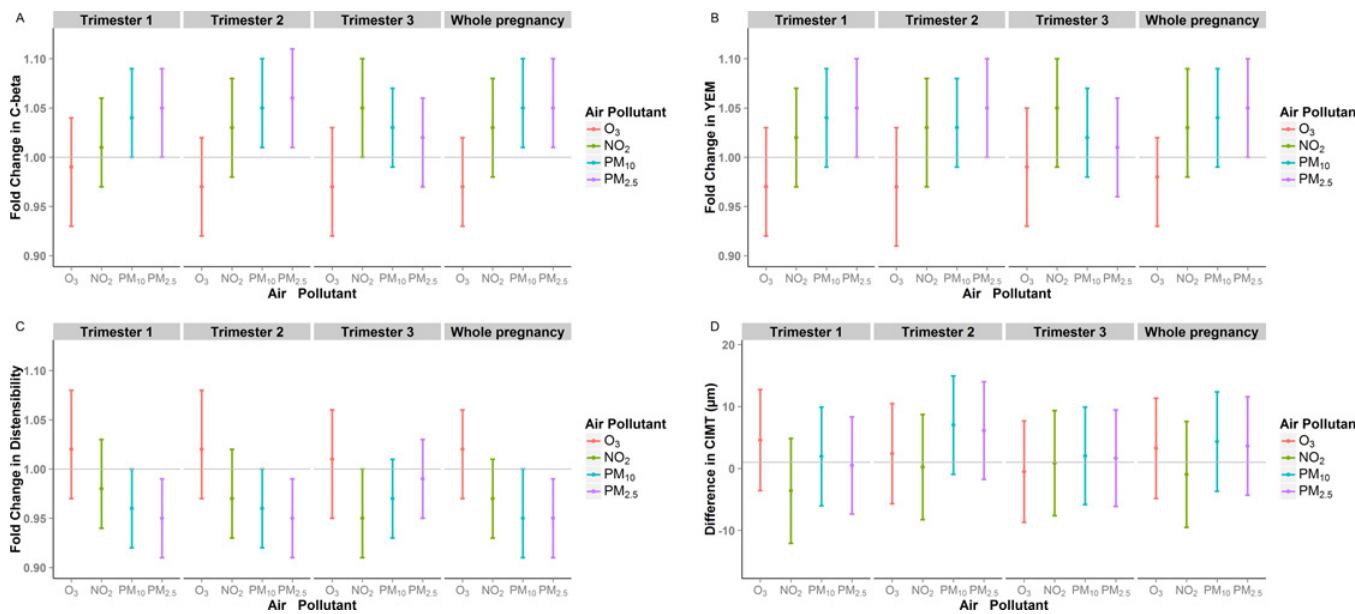
Fig 1. The association between prenatal air pollutant exposures and A) C-beta, B) YEM, C) Distensibility, and D) CIMT, by trimester and whole pregnancy.